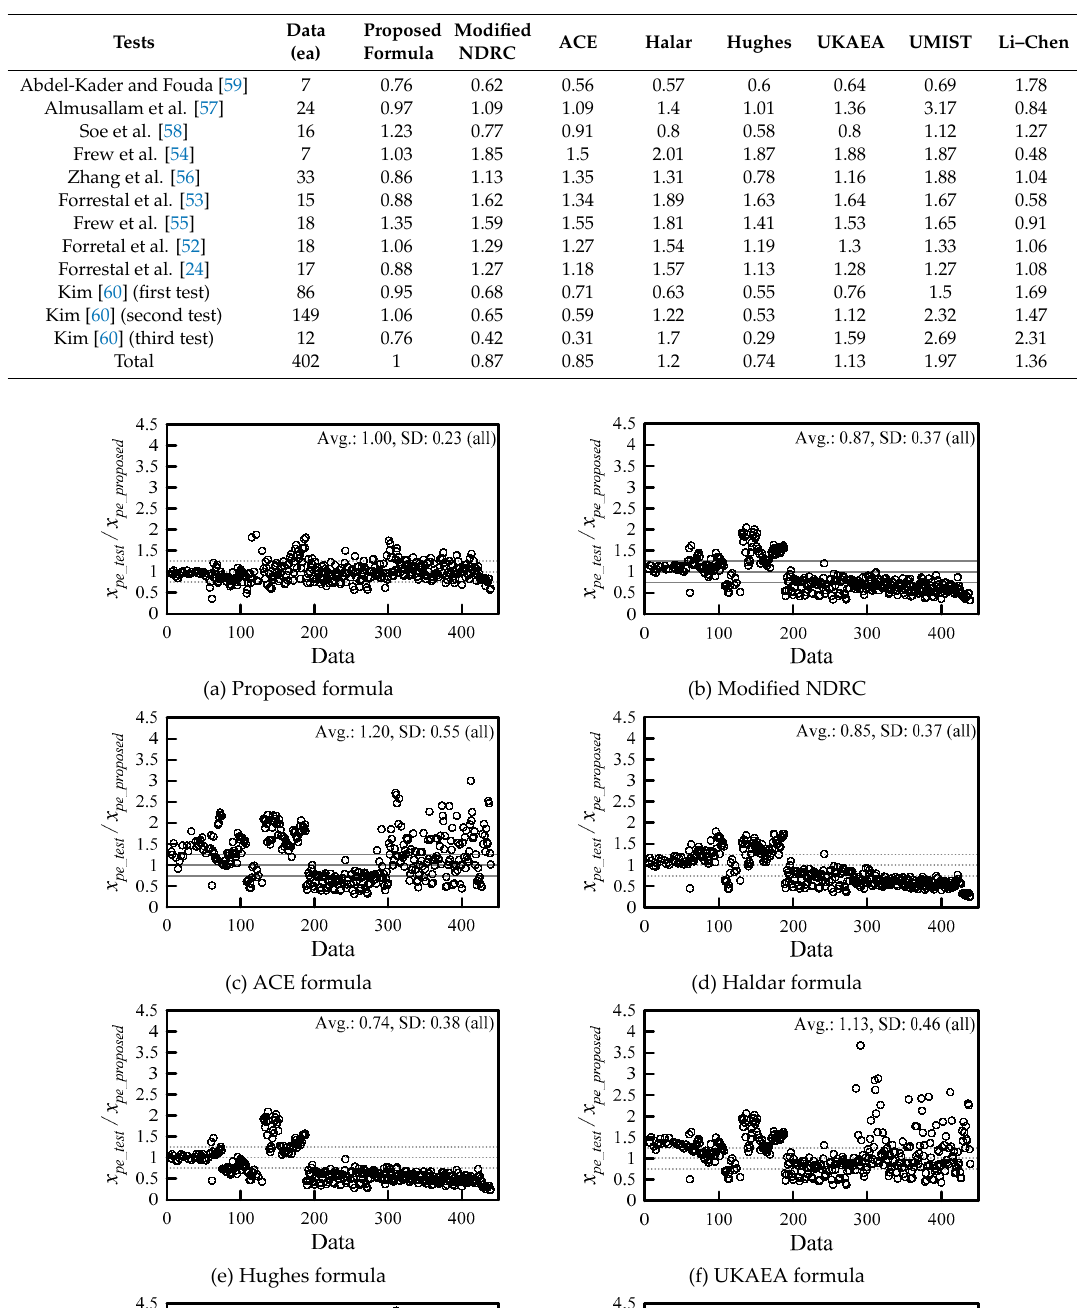
Table 2. Average ratio of tested to predicted penetration.